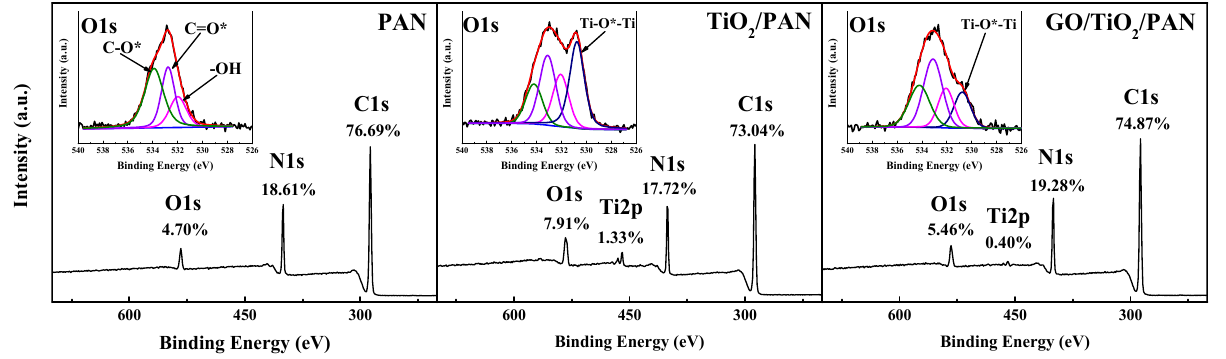
Figure 3. XPS spectra of the PAN, TiO 2 /PAN and GO/TiO 2 /PAN membranes. * indicates the element being analyzed.